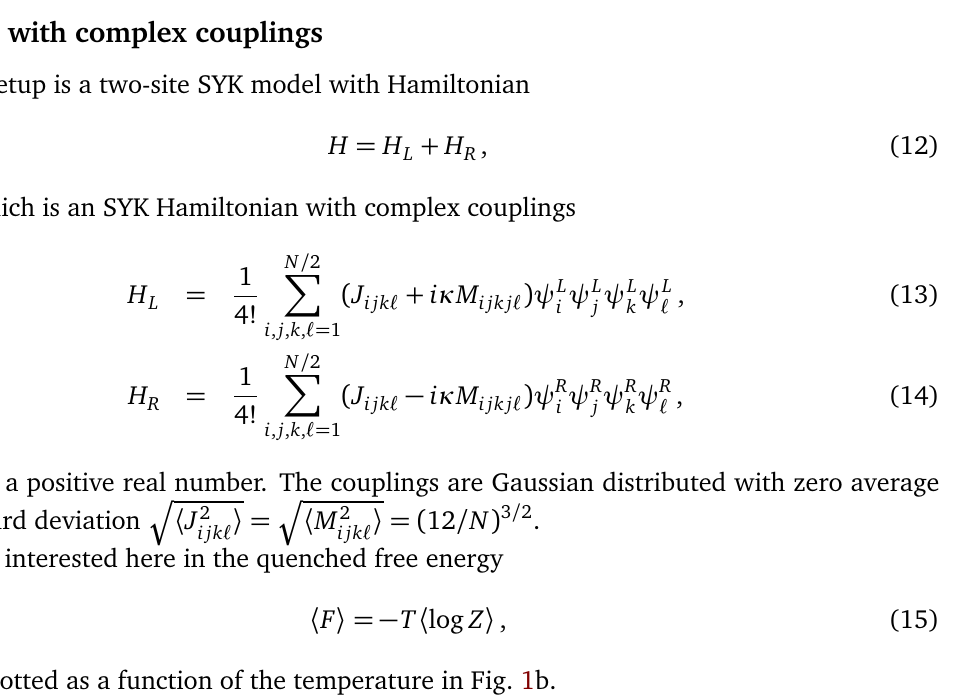
Figure 1: Free energy of the JT gravity and the two site complex SYK setup of Ref. [ 48 ] for N = 34 Majoranas on each site after performing a quench average over 45 dis- order realizations. In both cases, we observe a first order phase transition at low